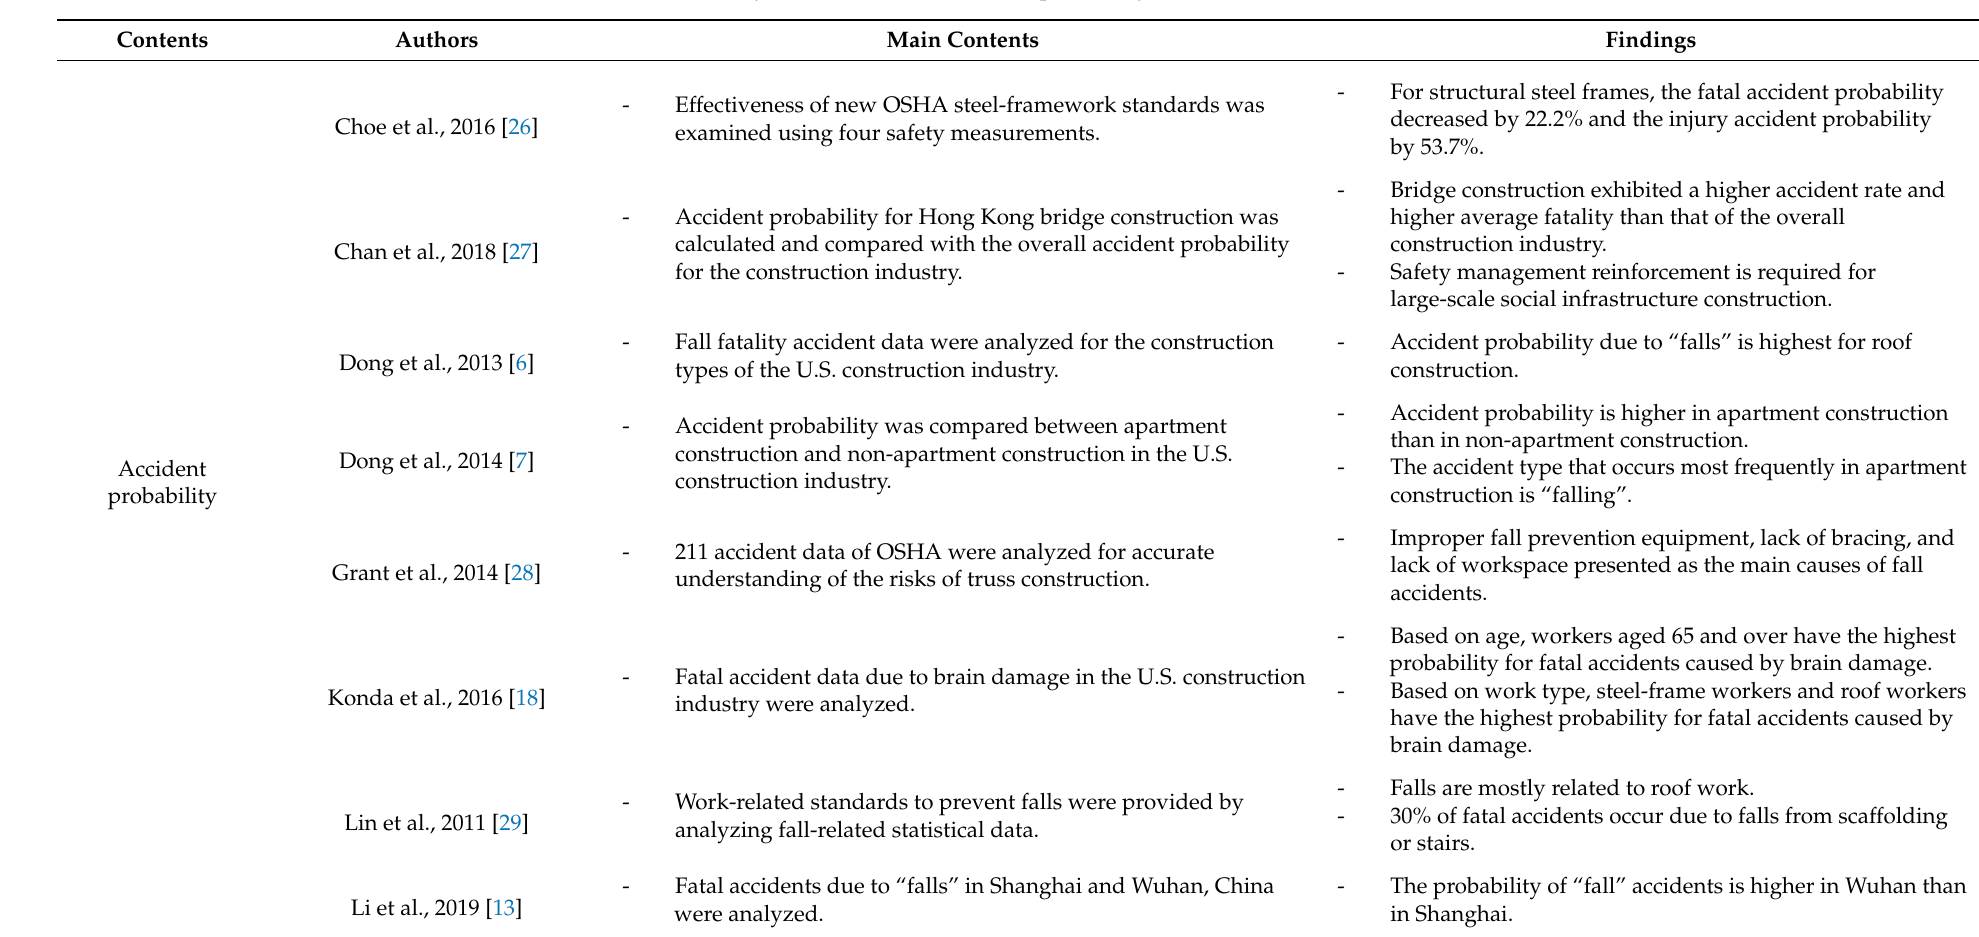
Table 1. Literature review on the analysis of construction accident probability, accident cost, and risk